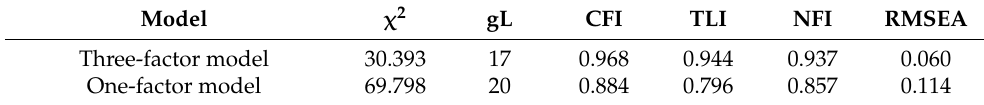
Table 7. Factorial confirmatory analysis of ABA-SF